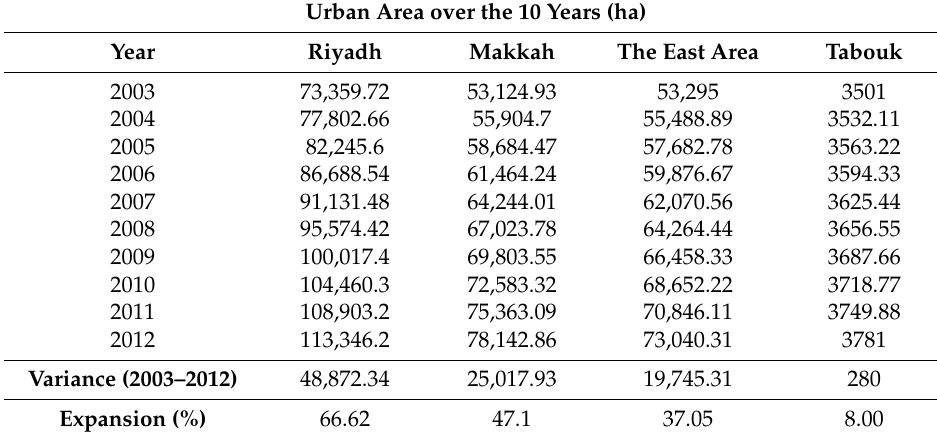
Table 3. Urban change over